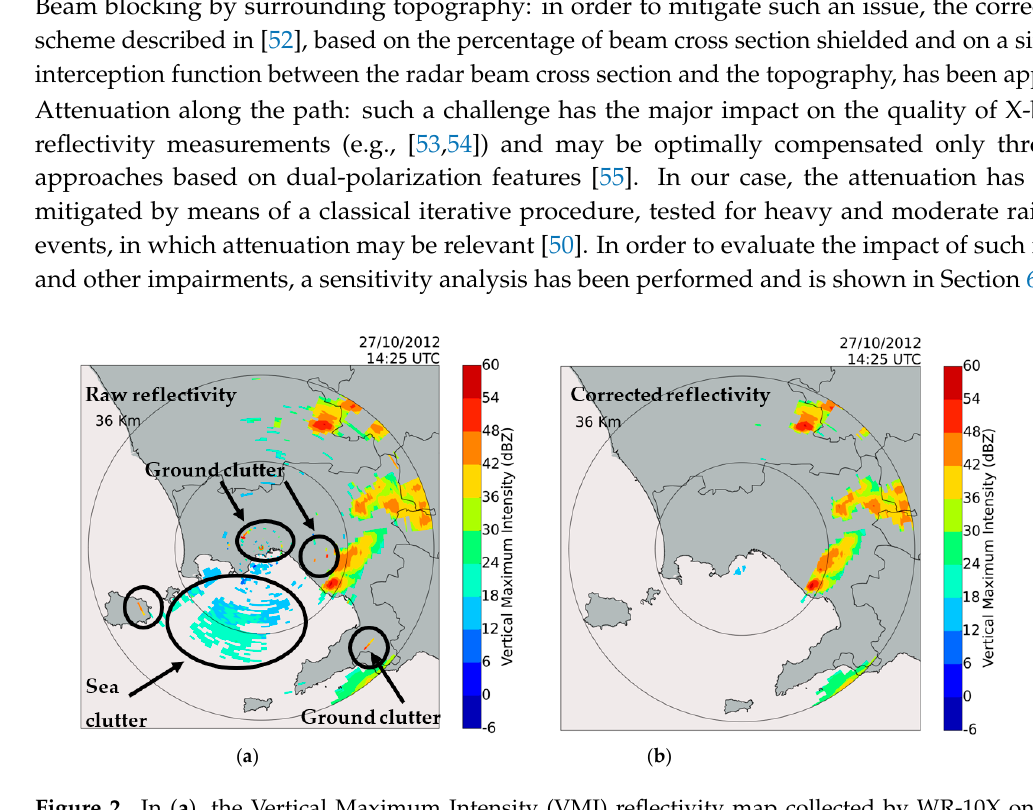
Table 2. Technical features of WR-10X weather radar operating in Naples urban area.